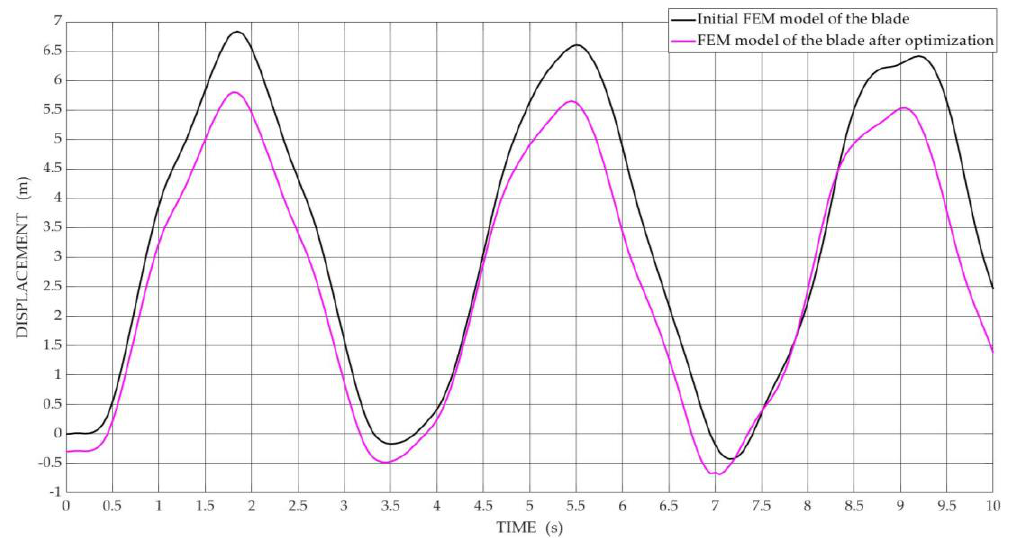
Figure 8. The diagram of vibration displacements in the transverse direction is determined in the node located at the tip of the blade span for the initial FEM model and the FEM model after optimi- zation.